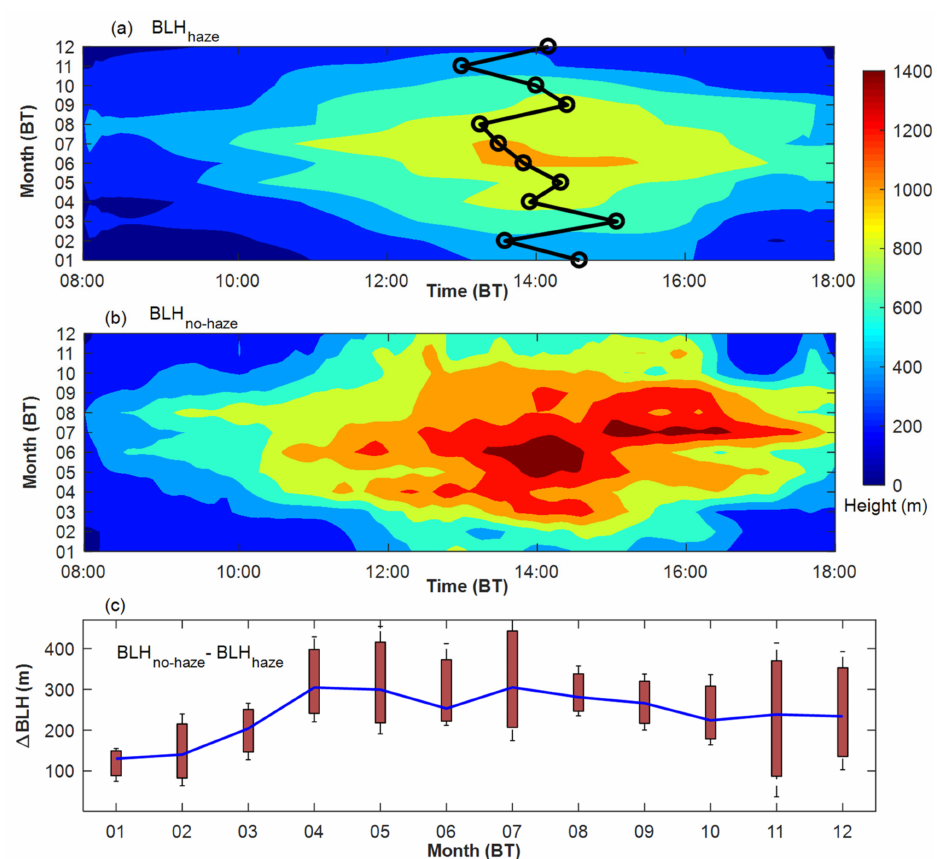
Figure 5. ( a ) Temporal distribution of the BLH haze in different months; the black line indicates the time of the highest boundary layer. ( b ) The temporal distribution of the BLH no − haze in different months. ( c ) Differences in the BLH no − haze and BLH haze